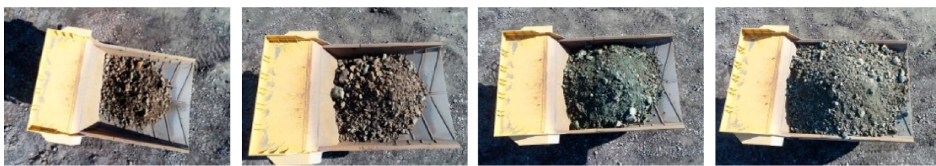
Figure 6. Part of the supplementary test set images.